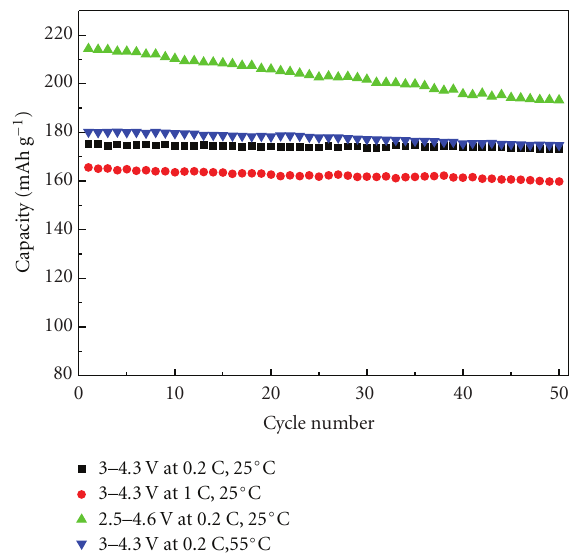
Figure 9: Specific discharge capacity of Li/Li[Ni 0 . 5 Mn 0 . 3 Co 0 . 2 ]O 2 cell as a function of cycle number under di ff erent charge/discharge